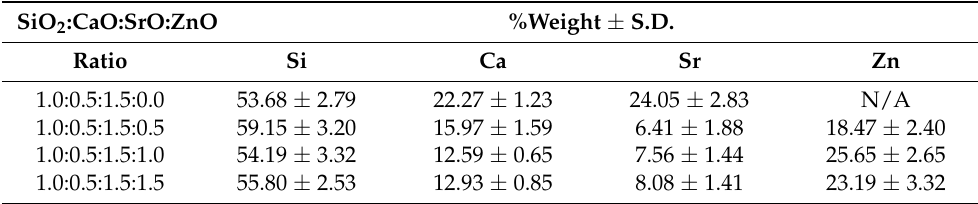
Table 4. Elemental composition of Zn-BAGNPs with the two-step post-functionalisation process after the extra washing process.